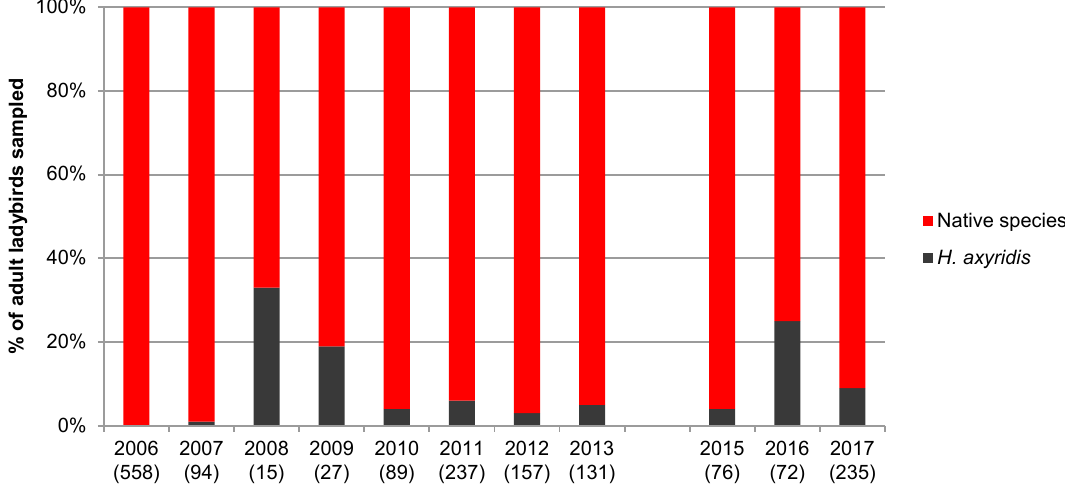
Figure 2. Percentage of Harmonia axyridis and native species in the 15 meadows from 2006 to 2017. Numbers between parentheses indicate the number of adult ladybirds collected. Table 2. Species and number of adult ladybirds collected in the 15 meadows from 2006 to 2017. Numbers between parentheses indicate the number of collections. Ladybirds were not sampled in 2014.